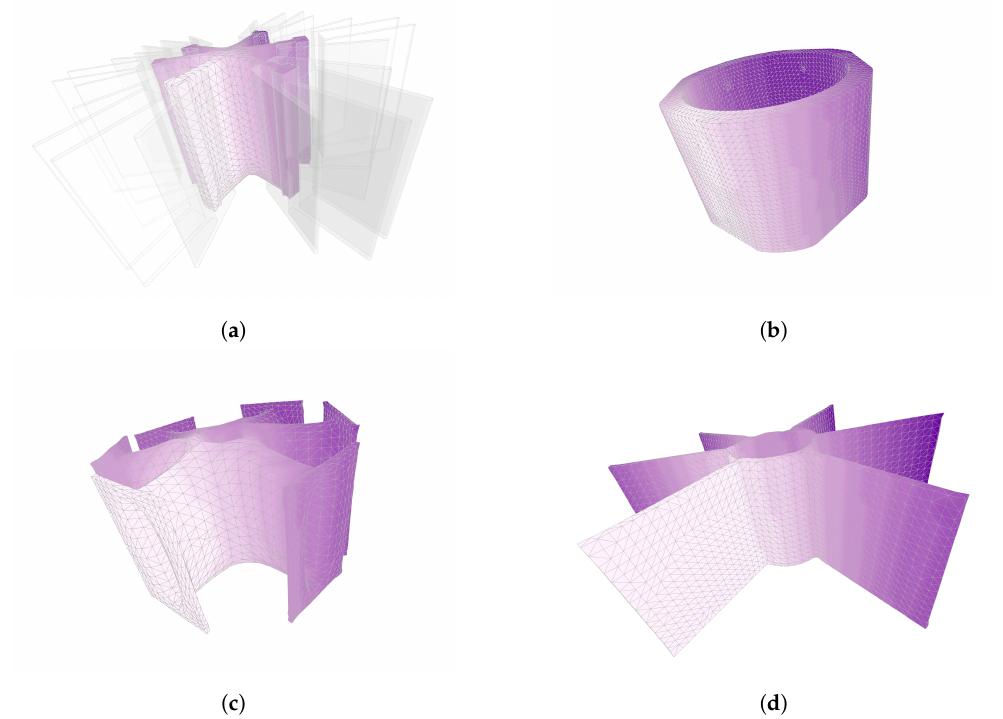
Figure 13. Displacement plots of the nodes. The hue of the colour illustrates the magnitude of displacements. ( a ) Displacements in the Glued Finger Node. ( b ) Displacements in the Mero ZK. ( c ) Displacements in the Starnode. ( d ) Displacements in the Polo-1.